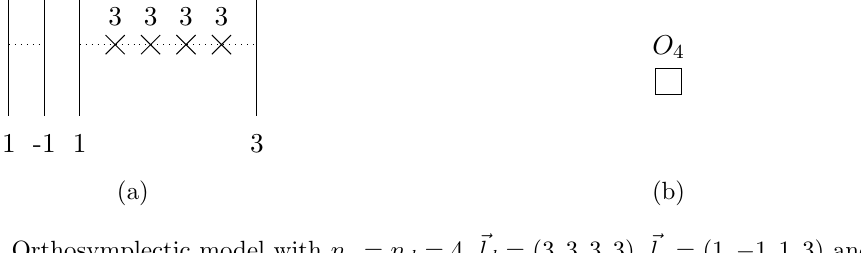
Figure 22. Orthosymplectic model with n s = n d = 4, ~l d = (3 ; 3 ; 3 ; 3), ~l s = (1 ; (cid:0) 1 ; 1 ; 3) and right- most orientifold plane O 3 (cid:0) . The quiver is trivial and can be read from (a), and it is depicted in (b).